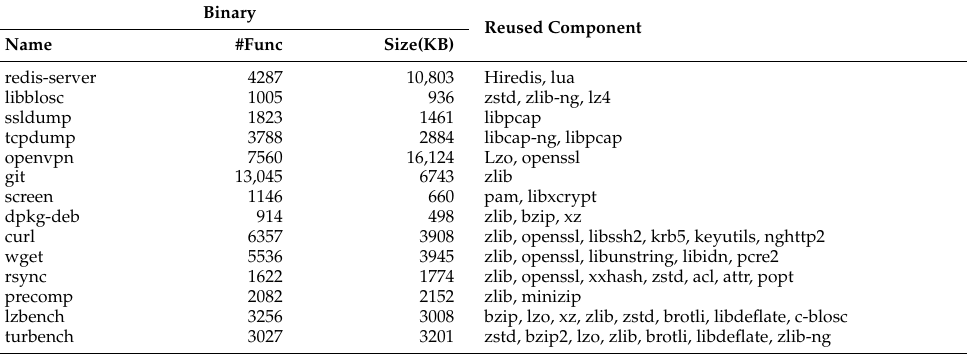
Table 3. Dataset I used for